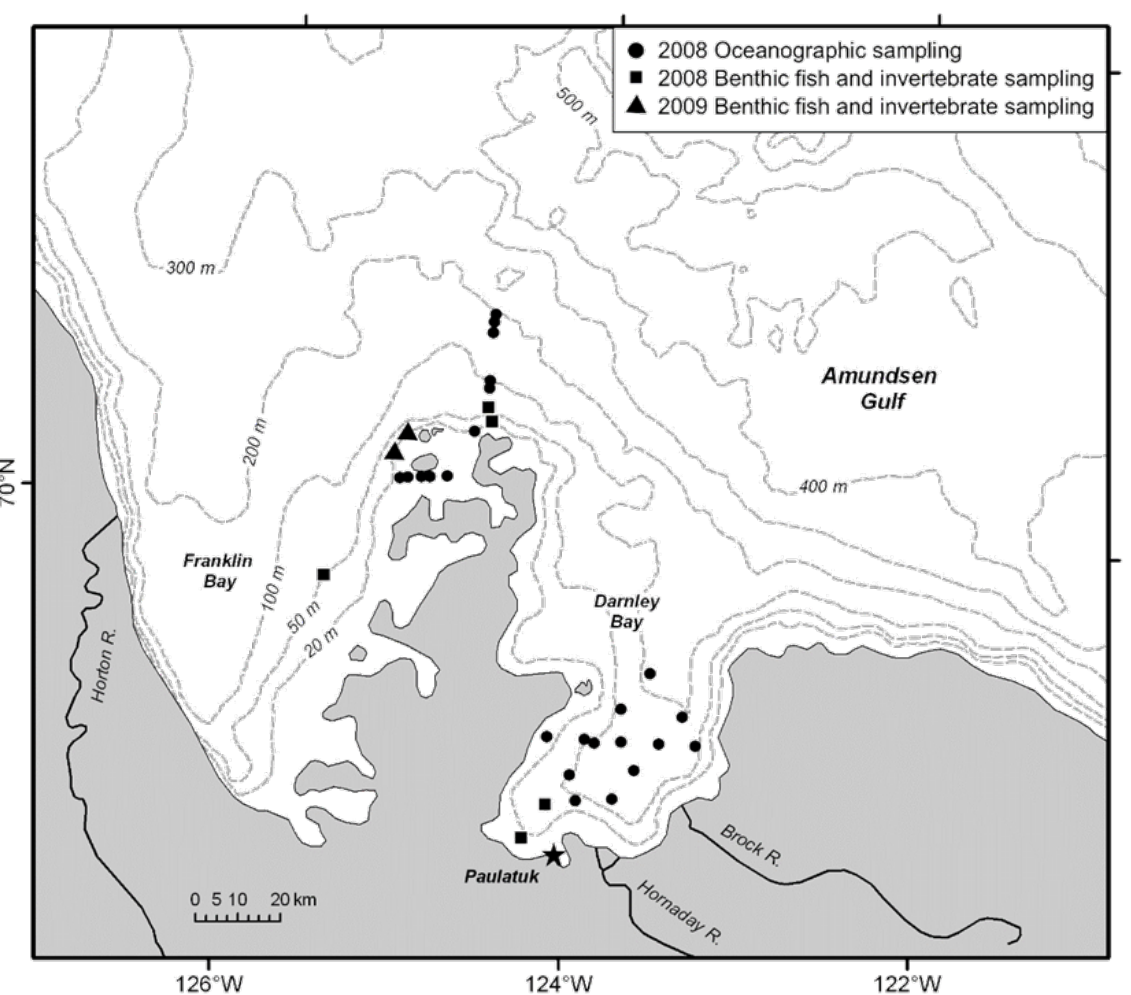
Figure 6. Stations sampled in the vicinity of the ANMPA during the Northern Costal Marine Study in 2008 and 2009 from the CCGS Nahidik. Oceanographic sampling typically included full profiles for physical and chemical oceanography, and occurred at both fish and invertebrate sampling stations (squares and triangles) as well as at dedicated oceanographic stations (circles). Map modified from Paulic et al. 2012 and Lowdon et al.